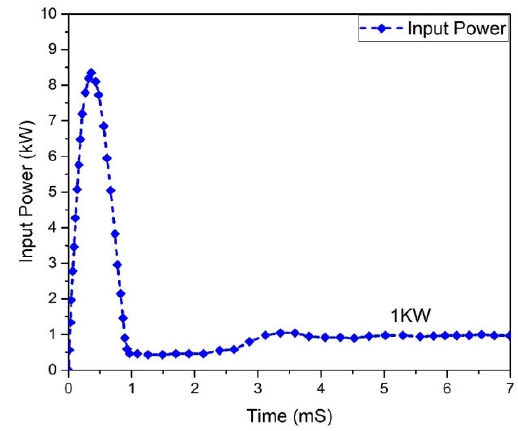
Figure 27. Input power (GaN-HEMT).